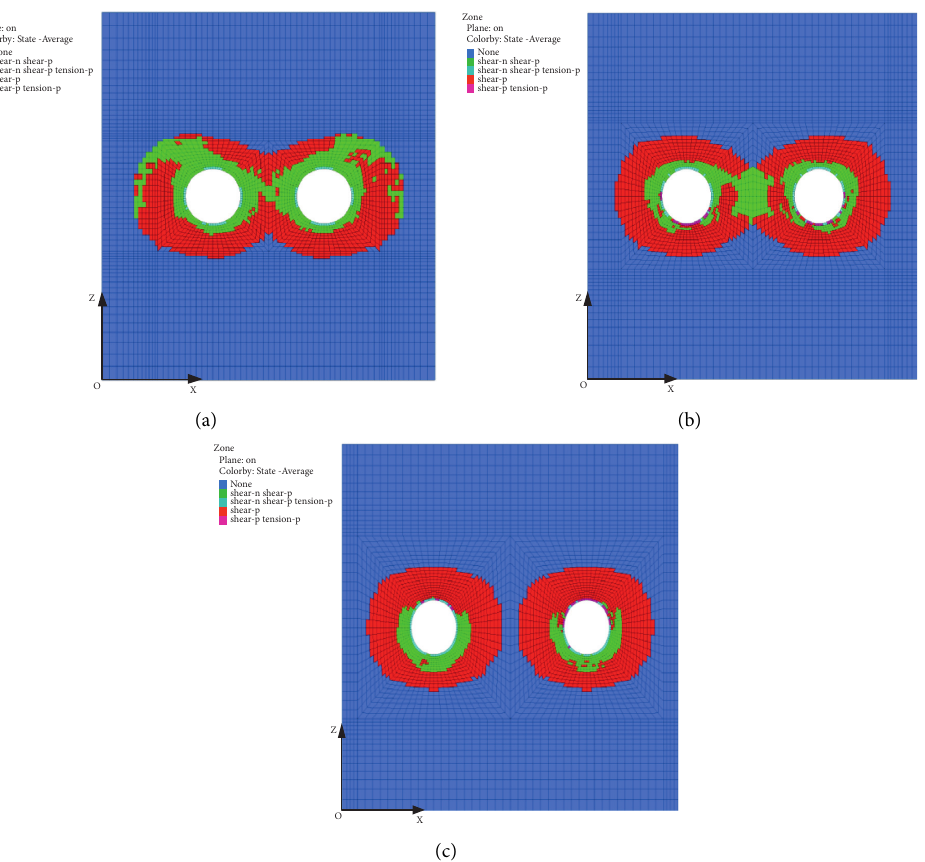
Figure 17: Distribution of the plastic zone around the slot with different spacings in Section 1. (a) 3.0m. (b) 4.0m. (c) 5.0 m. shear-pNoneZone Plane: on Colorby: State -Average